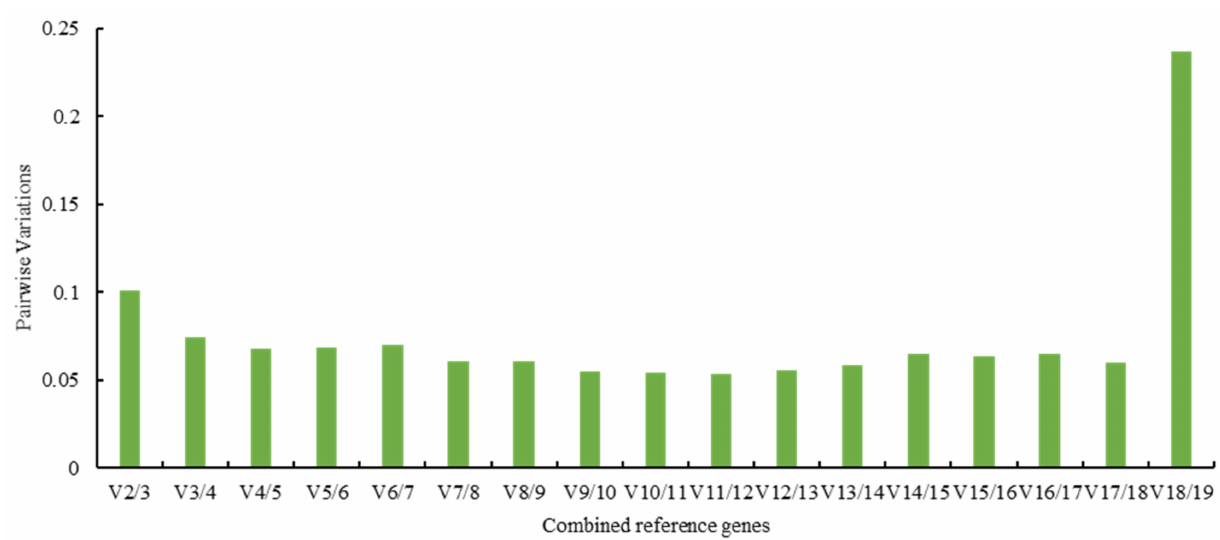
Figure 2. Pairwise variation (V) of candidate reference genes calculated by geNorm. NormFinder ranked the expression stability of reference genes by calculating the average pairwise variation in one gene relative to other candidate genes. The smaller the stability value, the more suitable it is as a reference gene [27]. For different tissues, the most stable gene was SsuACT , followed by SsuRIB , while the least stable gene was SsuCas , which was not included with the genes selected by geNorm (Figure